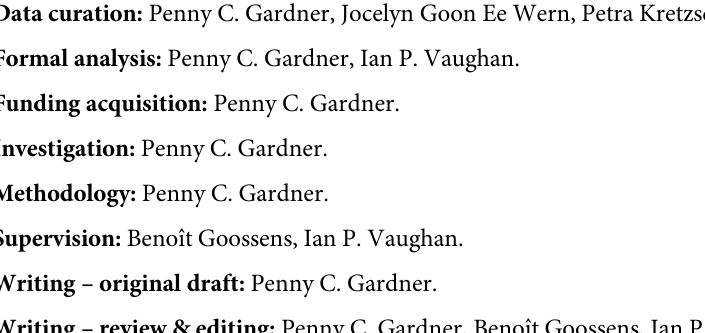
S1 Fig. Description of logging methods. Four different methods of logging used in Sabah (Malaysia Borneo) within tropical dipterocarp forests over the past six decades up until pres- ent-day: conventional, traditional and newer Reduced Impact Logging (RIL) techniques. Tra- ditional logging methods are more destructive and result in heavy impaction of the substrate, which provides favourable conditions for invasive pioneer species that banteng forage upon. S1 Table. GLM estimates of bootstrapped models. GLMs constructed to obtain two-hourly estimates and 95% confidence intervals for activity patterns of Bornean banteng, ambient tem- perature, activity budgets (grazing, travelling and other behaviours) and habitat use (Old log- ging roads, open areas, forest trails and active access roads) in three regenerating forests in Sabah, Malaysia. S2 Table. Data